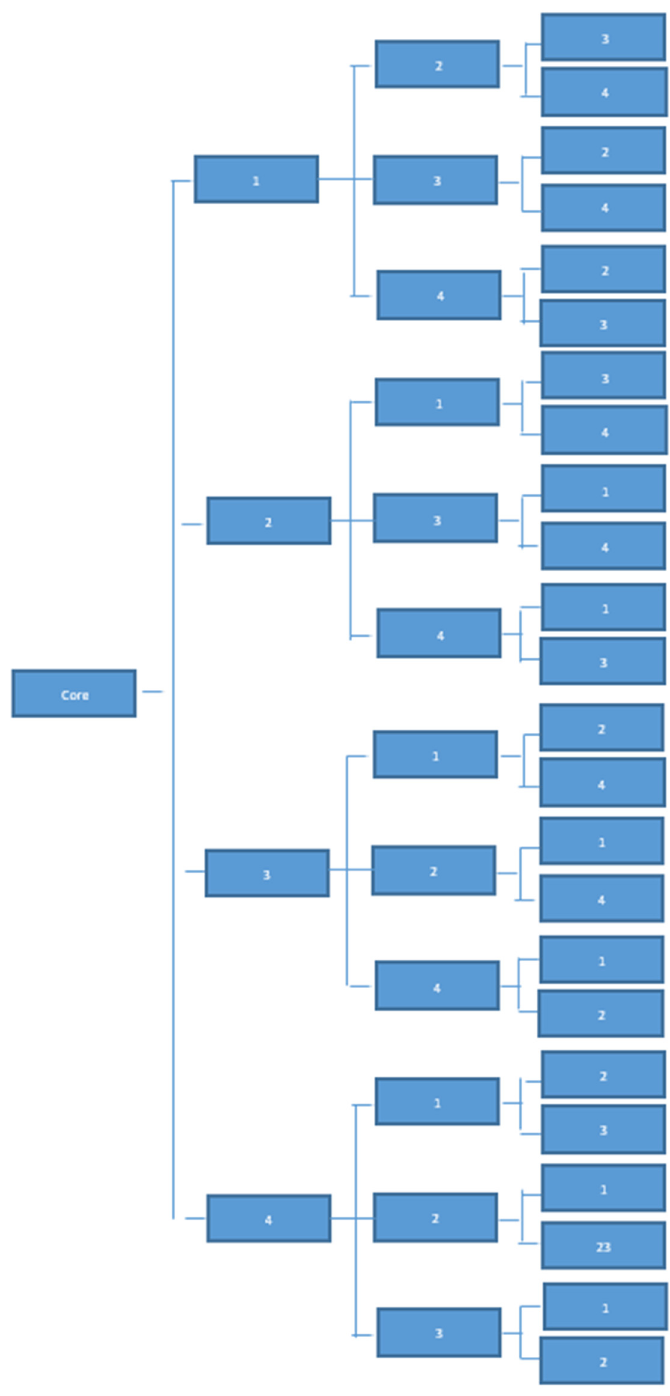
Figure 1. Questback randomization process. Note: 1 = cultural and psychosocial aspects; 2 = personality and geographical barriers; 3 = interpersonal processes; 4 = employment, costs and migrant care work.